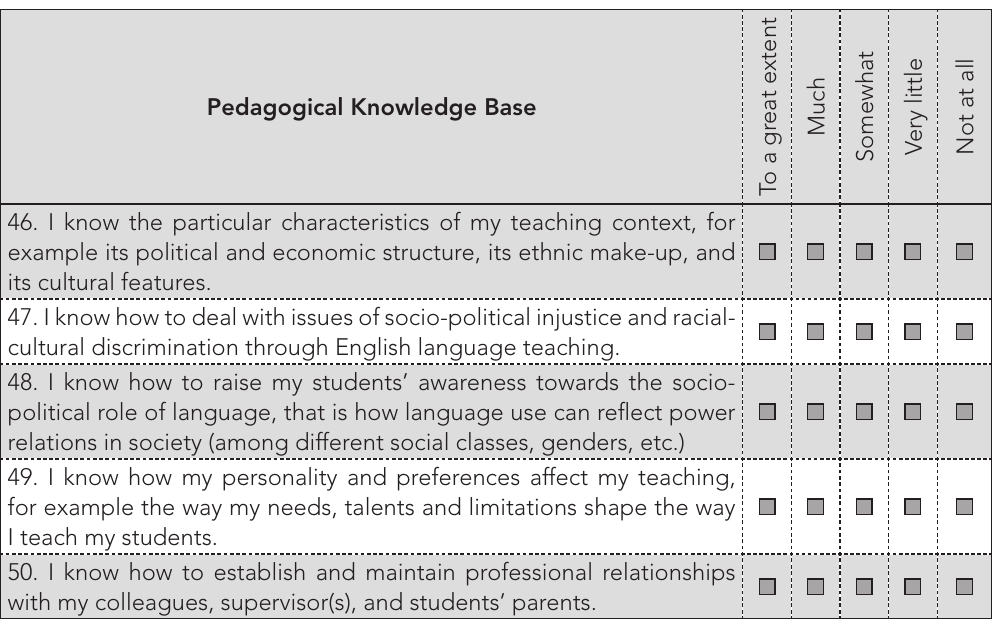
Figure 3: Self-assessment questionnaire of pedagogical knowledge